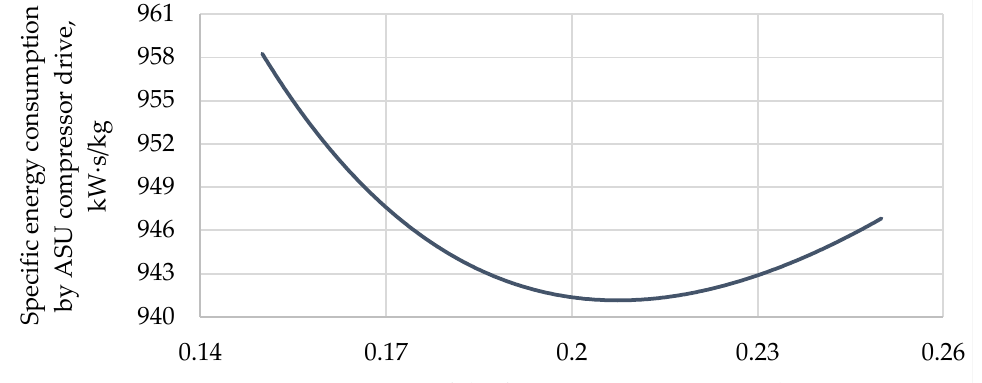
Figure 8. Dependence of the specific energy consumption of an ASU compressor drive with a single- stage intercooled compressor.